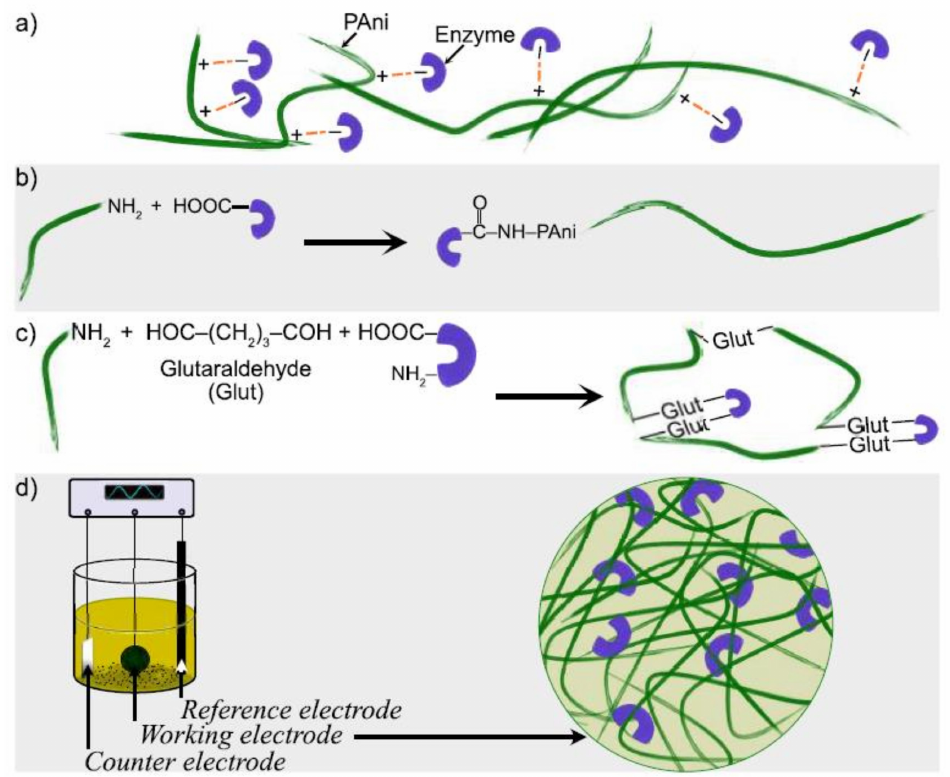
Figure 8. Immobilization strategies for GO x in PAni-based biosensors: ( a ) Physical absorption, ( b ) covalent bonding, ( c ) crosslinking, ( d ) entrapment by